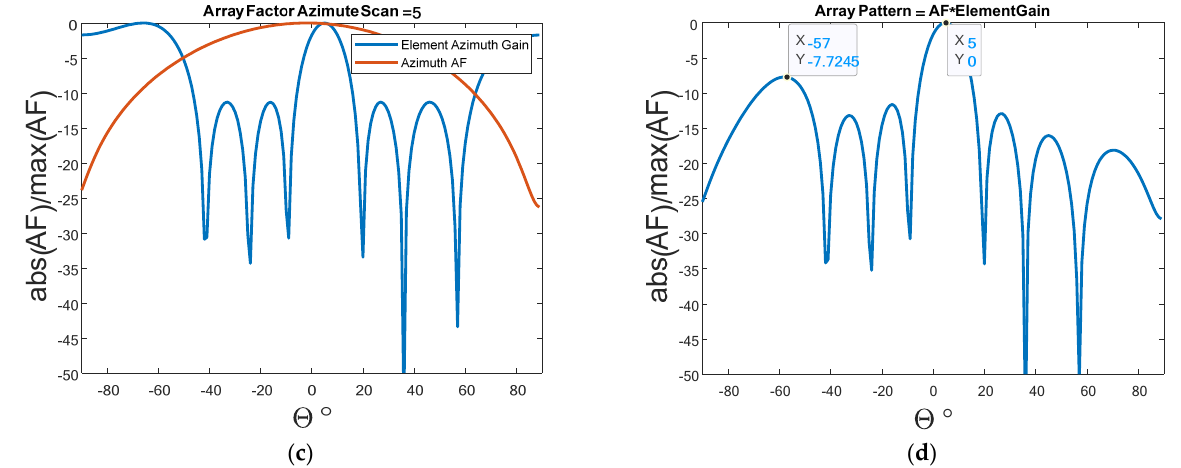
Figure 10. ( a ) Azimuth AF and Element Pattern of a dipole array without scanning; ( b ) Azimuth Array Pattern of a dipole array without scanning; ( c ) Azimuth AF and Element Pattern of a dipole array with azimuth scans of 5 degrees; ( d ) Azimuth Array Pattern of a Yagi–Uda array with azimuth scans of 5 degrees.